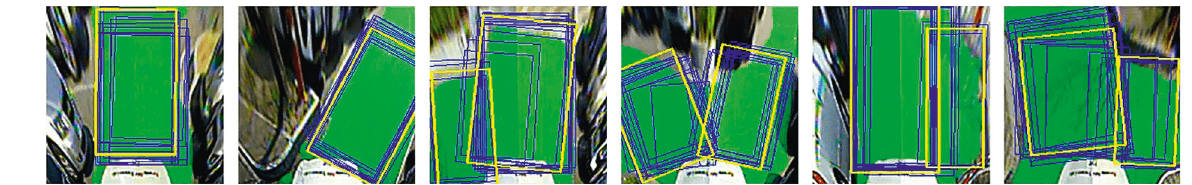
Figure 6: Nonmaximum suppression algorithm; blue box: raw output of detection decoder (not grouped); yellow box: finally detected (grouped) box through the blue boxes.